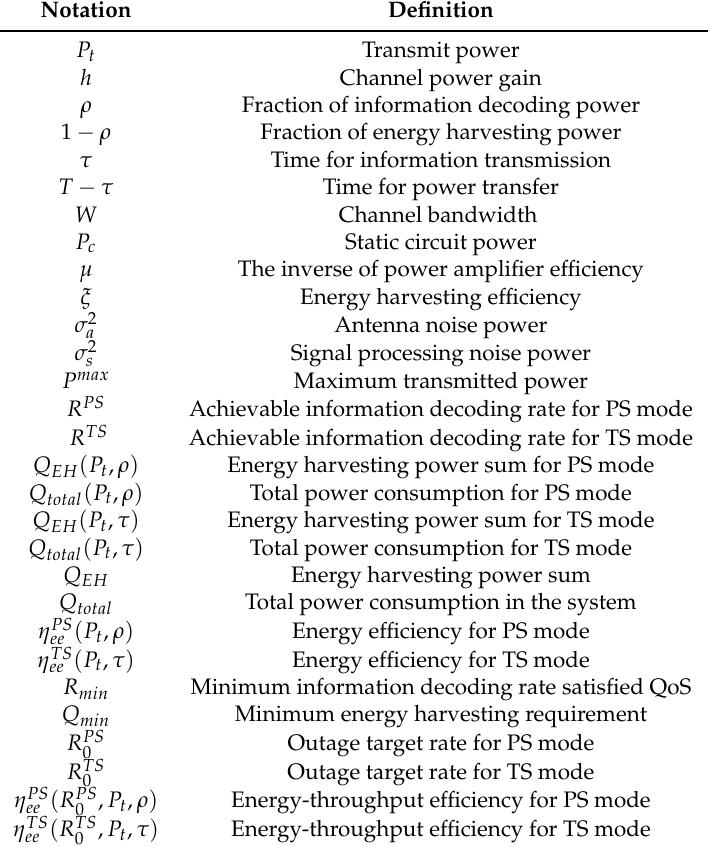
Table 1. List of